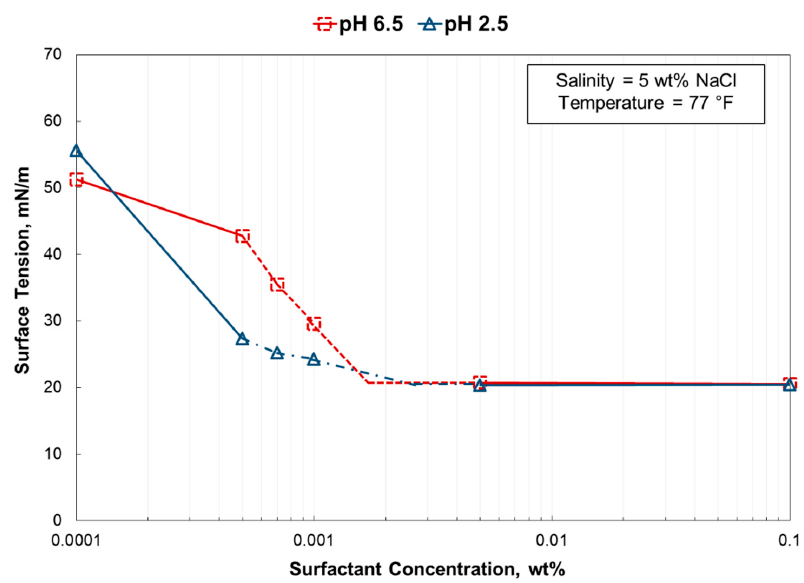
Figure 17. Effect of initial pH on surfactant solution interfacial properties at 5 wt% NaCl and 77 °F (25 °C).